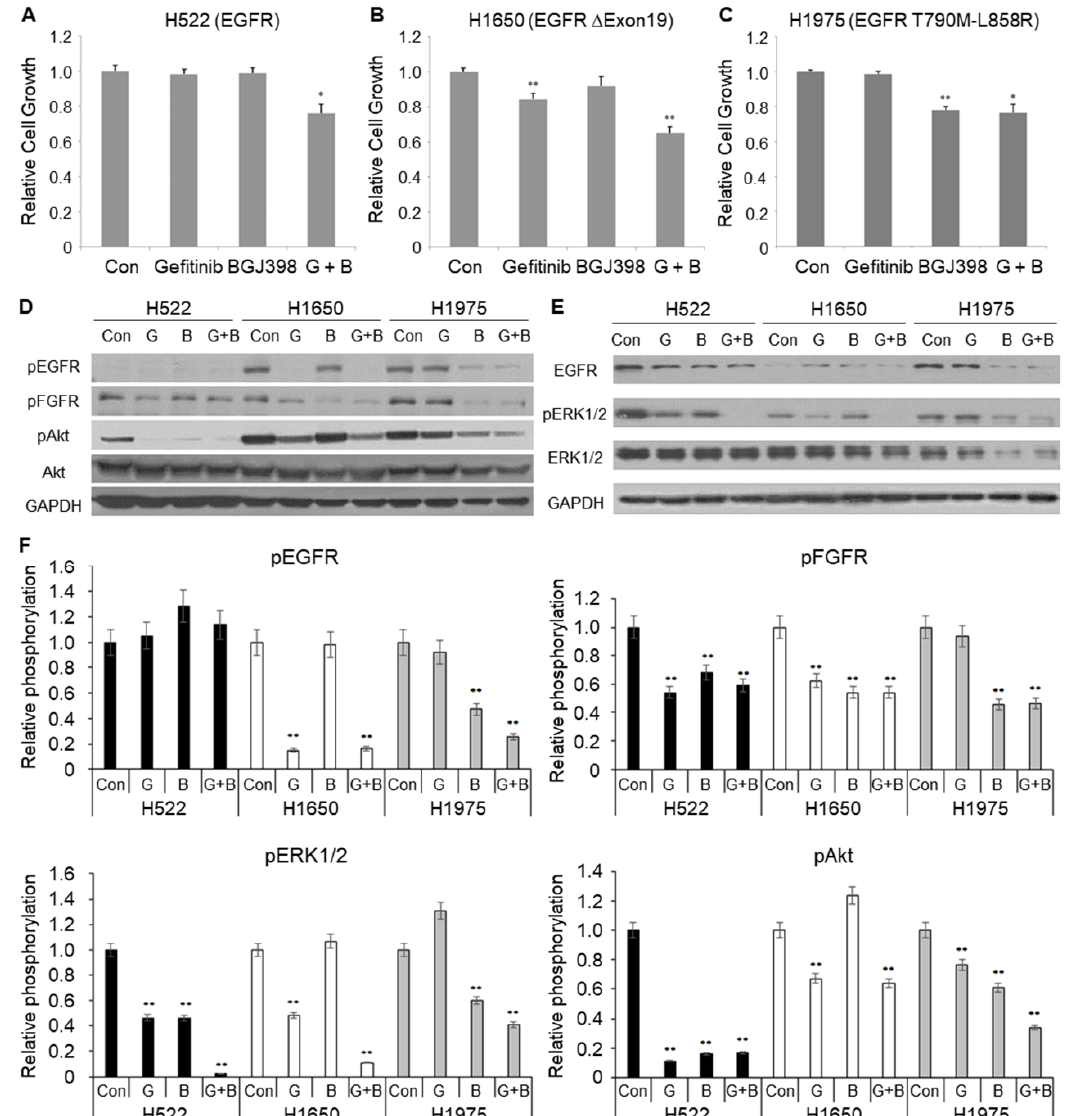
Figure 7. Effects of EGFR-TKI and FGFR-TKI on growth of lung cancer cell lines with different EGFR mutations. ( A – C ) Cells treated with 5 µ M gefitinib (G), 10 µ M BGJ398 ( B ) or two together (G + B) for 24 hours and cell growth was assessed by MTS assay. Error bar = SEM. ( D , E ) Cells treated as in ( A – C ) were lysed and each 20 µ g of total protein was analyzed by immunoblotting using the indicated antibodies. GAPDH was used as a loading control. ( F ) Levels of pEGFR, pFGFR, pERK1/2, and pAkt were analyzed by densitometry and normalized with GAPDH. Fold changes relative to control were presented. Relative phosphorylation indicates relative fold of phosphorylation level of each protein. Error bar = SD. (* p < 0.05 and ** p < 0.01 versus Con). These experiments were performed three times with comparable results.